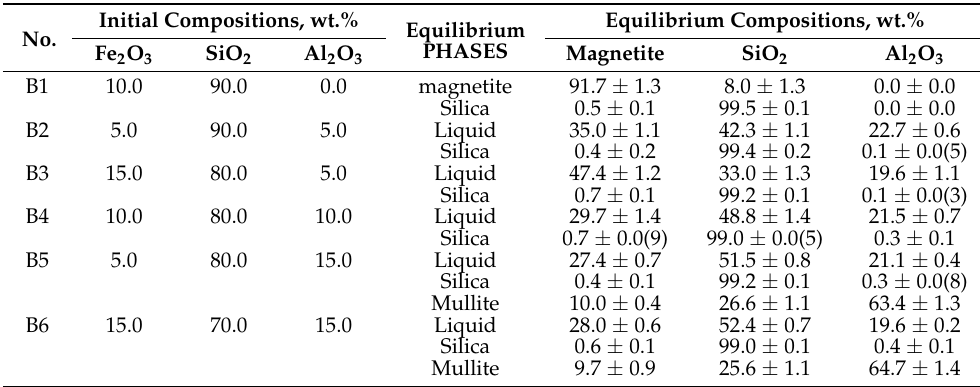
Equilibrium Compositions, wt.% Equilibrium PHASES